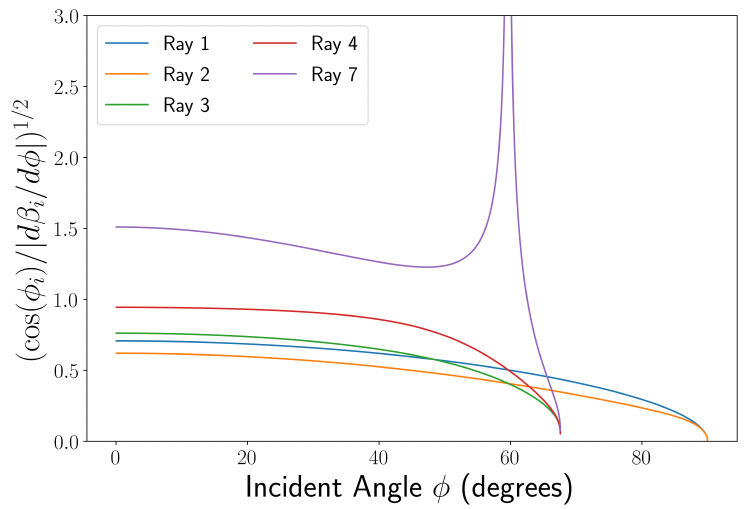
Figure 3. A graph showing the change of f i with incident angle as set out in Equation (3). All rays excluding ray 5 and ray 6 are shown here due to suppression from the capillary geometry considered. Parameters used were r / R = 0.74, n 1 = 1.457, n 2 = 1.333. The cut off for rays 3, 4, and 7 at φ i ∼ 70 ◦ is due to these rays being unable to enter the core above this